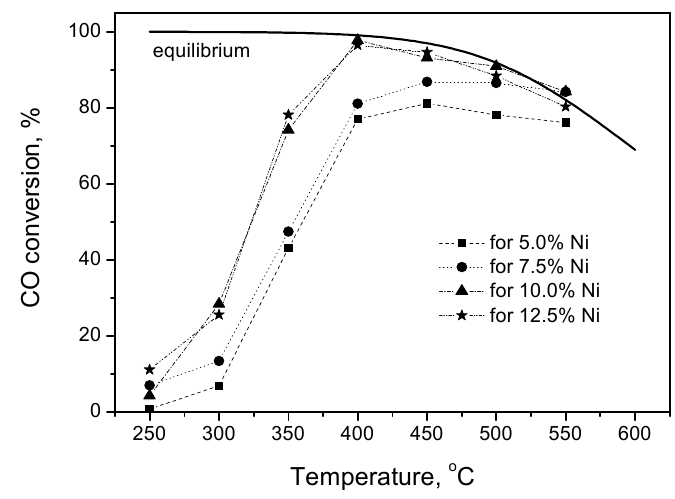
Figure 8. Temperature dependence of CO conversion at GHSV = 17640 h − 1 over catalysts with different nickel loading.